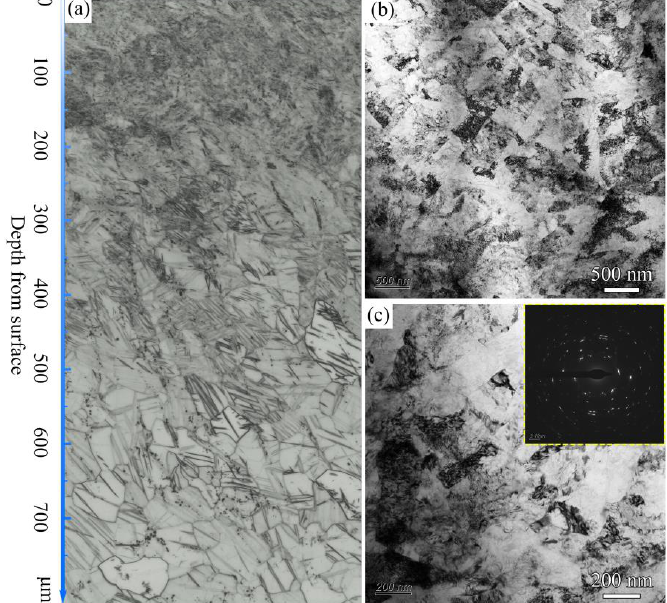
Figure 3. Microstructure of the GNS sample: ( a ) optical micrograph; ( b , c ) TEM images at the depth of about 20 µ m from the USSR processed surface. The insert in panel c shows the corresponding SAED pattern.